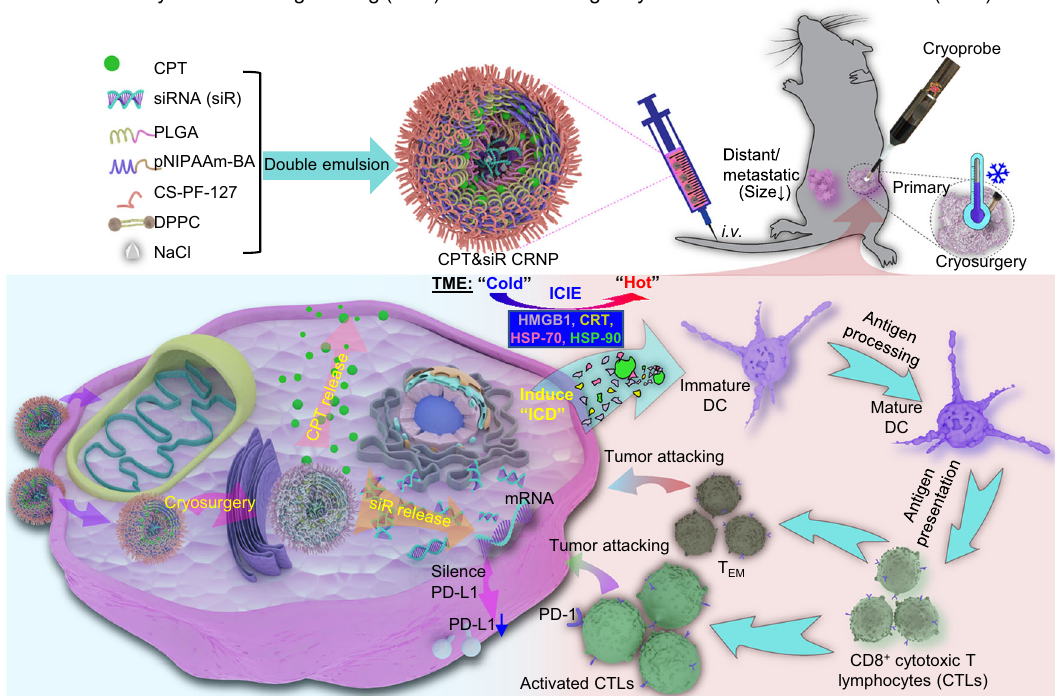
Fig.1|AschematicillustrationoftheICIEstrategyforkillingbothprimaryand distant/metastatic tumors. ICIE combines cryosurgery with intravenously injec- ted (i.v. ) irinotecan (or camptothecin/CPT) and PD-L1 silencing siRNA (siR)-laden cold-responsive nanoparticles (CPT&siR CRNPs) to engineer the tumor micro- environment(TME),viapromotingimmunogeniccelldeath(ICD)andreducingthe expression of programmed death Ligand 1 (PD-L1) in cancer cells. This turns the TME from immunologically “ cold ” (i.e., immunosuppressive)into immunologically “ hot ” (i.e., immuno-active). As a result, the CD8 + T cells can be activated to exert